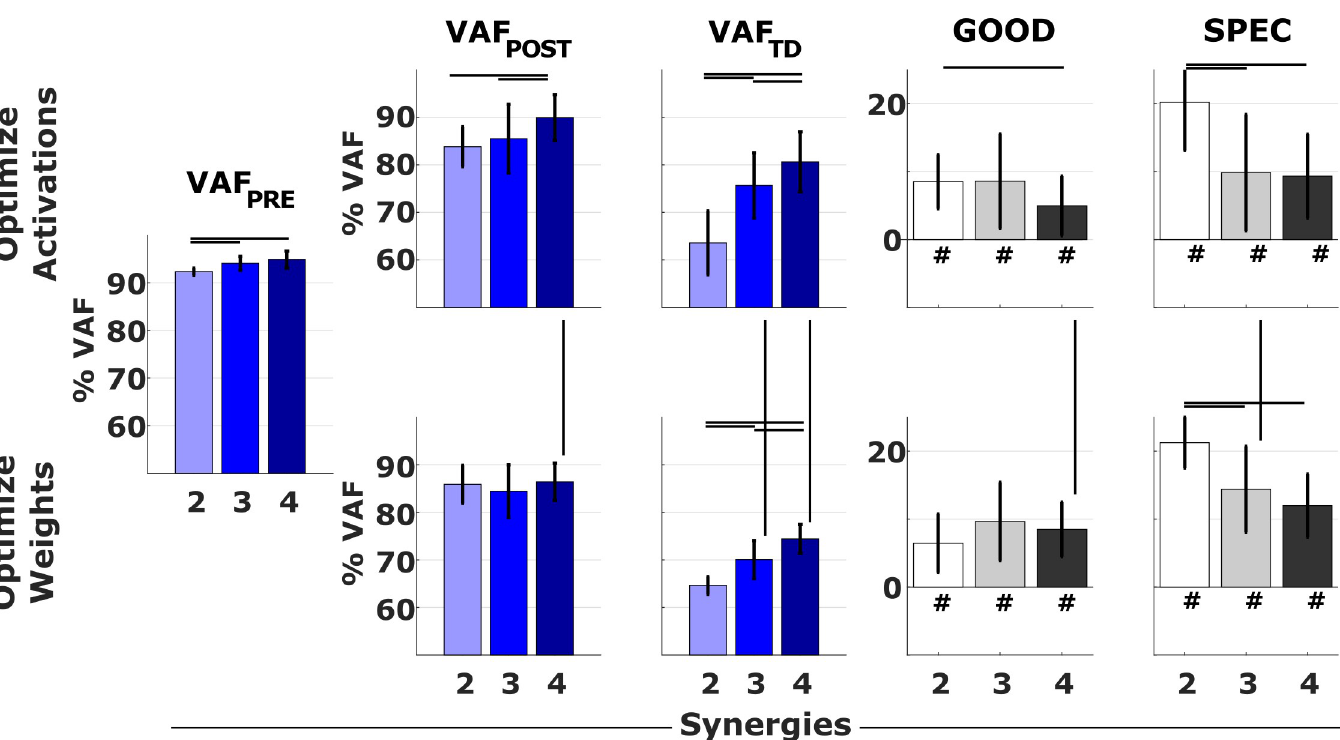
Fig 3. VAF when using subject–specific synergies. Results from the EMG reconstructions using pre-treatment muscle synergies. Colored bars report mean and standard deviation of the VAF values in the PRE, POST and TD conditions. Values for VAF PRE are defined during synergy extraction with NNMF. Grey bars report the mean and standard deviations of the differences GOOD = VAF PRE − VAF POST and SPEC = VAF POST − VAF TD computed on a subject-by-subject basis. Black lines indicate significant differences (p < 0.05). The symbol # indicates values of GOOD and SPEC that are significantly (p < 0.05) greater than zero.